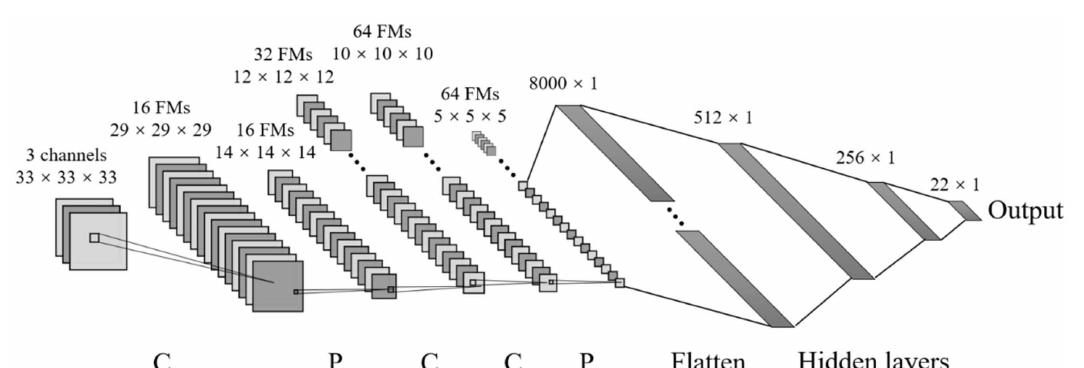
Figure 11. Three-dimensional convolutional neural network architecture (for simpler schematics, one gray rectangular represents one 3D input image). C is referred to as convolutional layer, P is max-pooling layer, and FMs denote the feature maps.